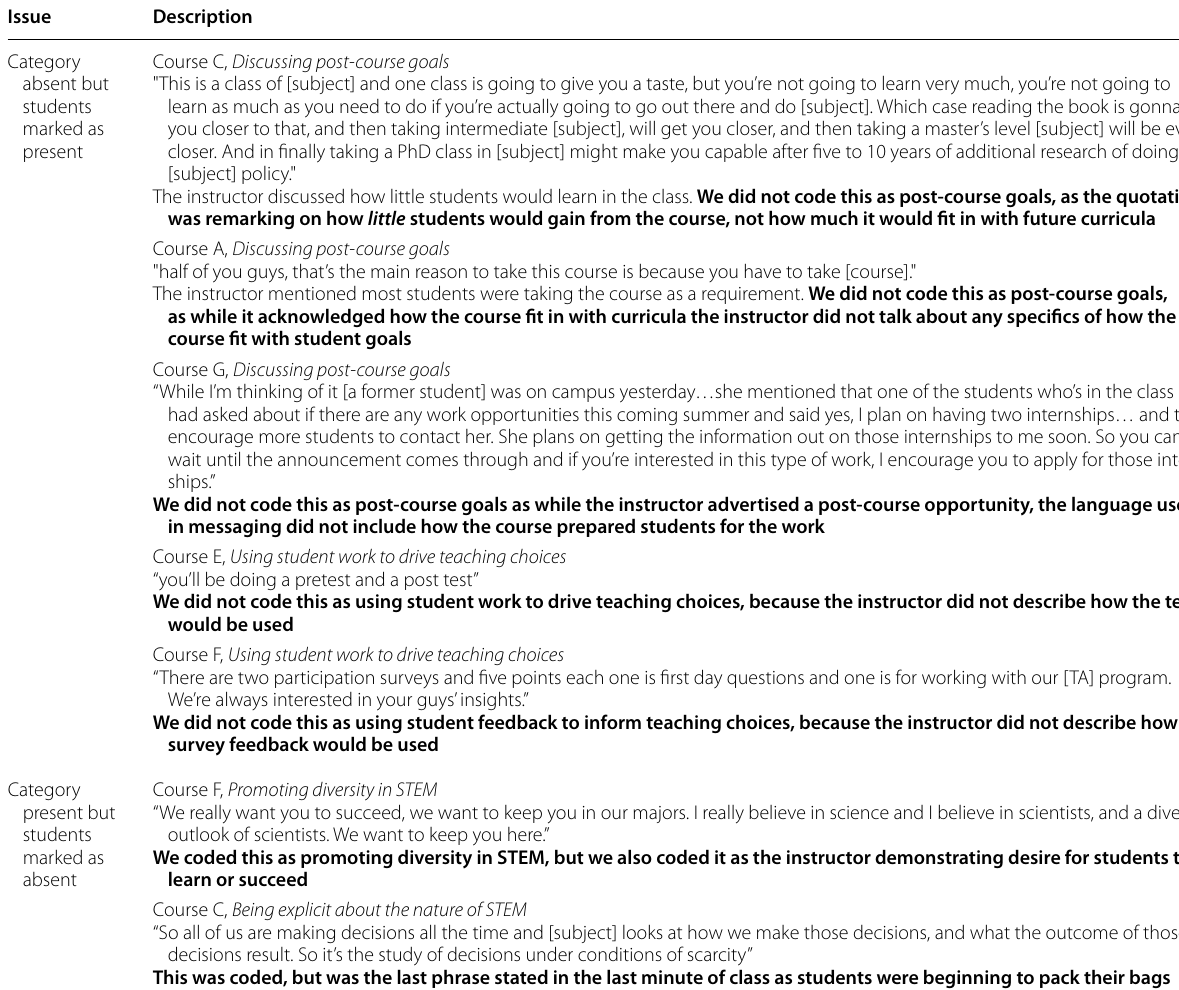
Table 3 A description of the seven cases where students reached agreement, but their agreement did not match what was observed in